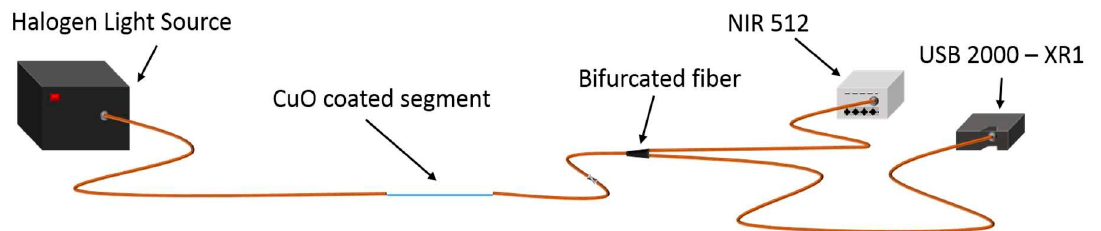
Figure 1. Experimental setup. The CuO coated segment of fiber is the sensitive region to refractive index variation.